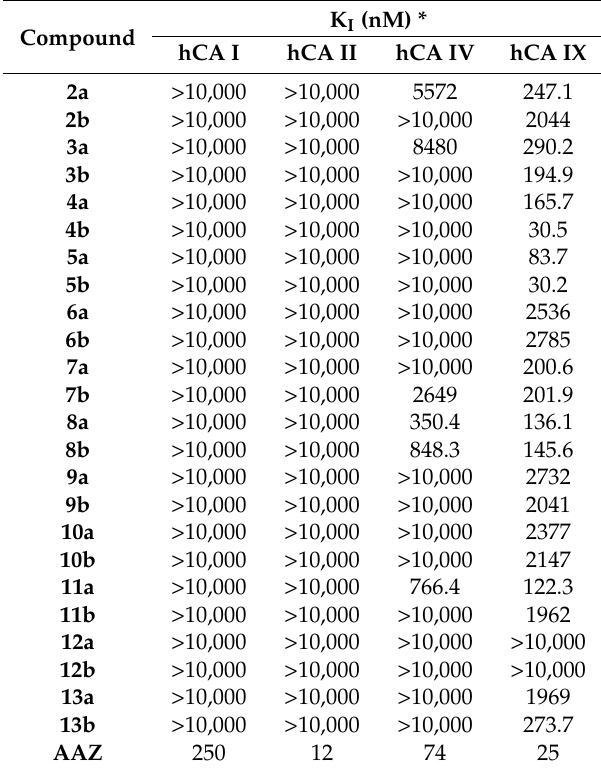
Table 1. Inhibition data of CA I, II, IV and IX with compounds reported here and the